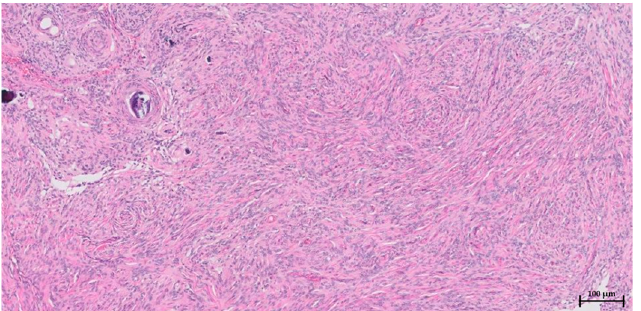
Figure 7. Microscopic picture of the incisional sample of the meningioma. It is densely packed with neoplastic cells supported by a fibrovascular stroma. Cellular nuclei are oval with finely stippled chromatin, with mild to moderate anisocytosis and anisokaryosis. The sample was diagnosed as the psammomatous subtype of meningioma with grade 1 (low grade) (H&E staining, scale bar = 100 µ